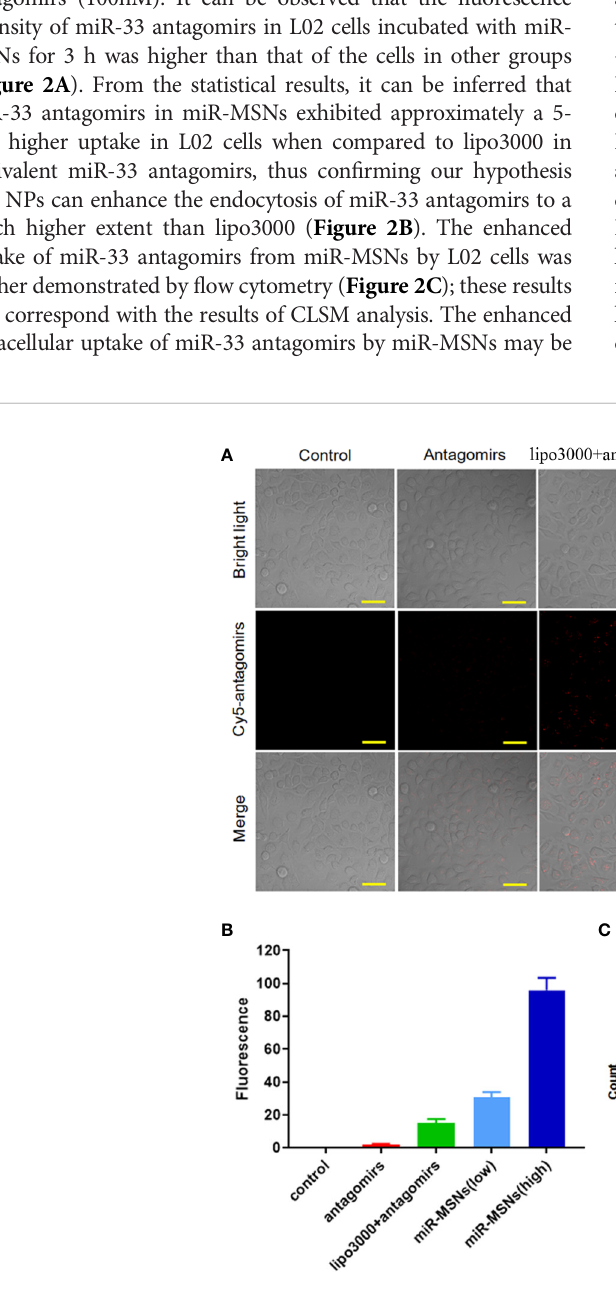
FIGURE 2 | Intracellular uptake analysis. (A) CLSM images of cells after incubation with different Cy5-antagomirs formulations. Scale bar = 50 µm. n=3. (B) Corresponding quantitative results of CLSM images. (C) Flow cytometric histogram pro fi les of L02 cells after 3 h of